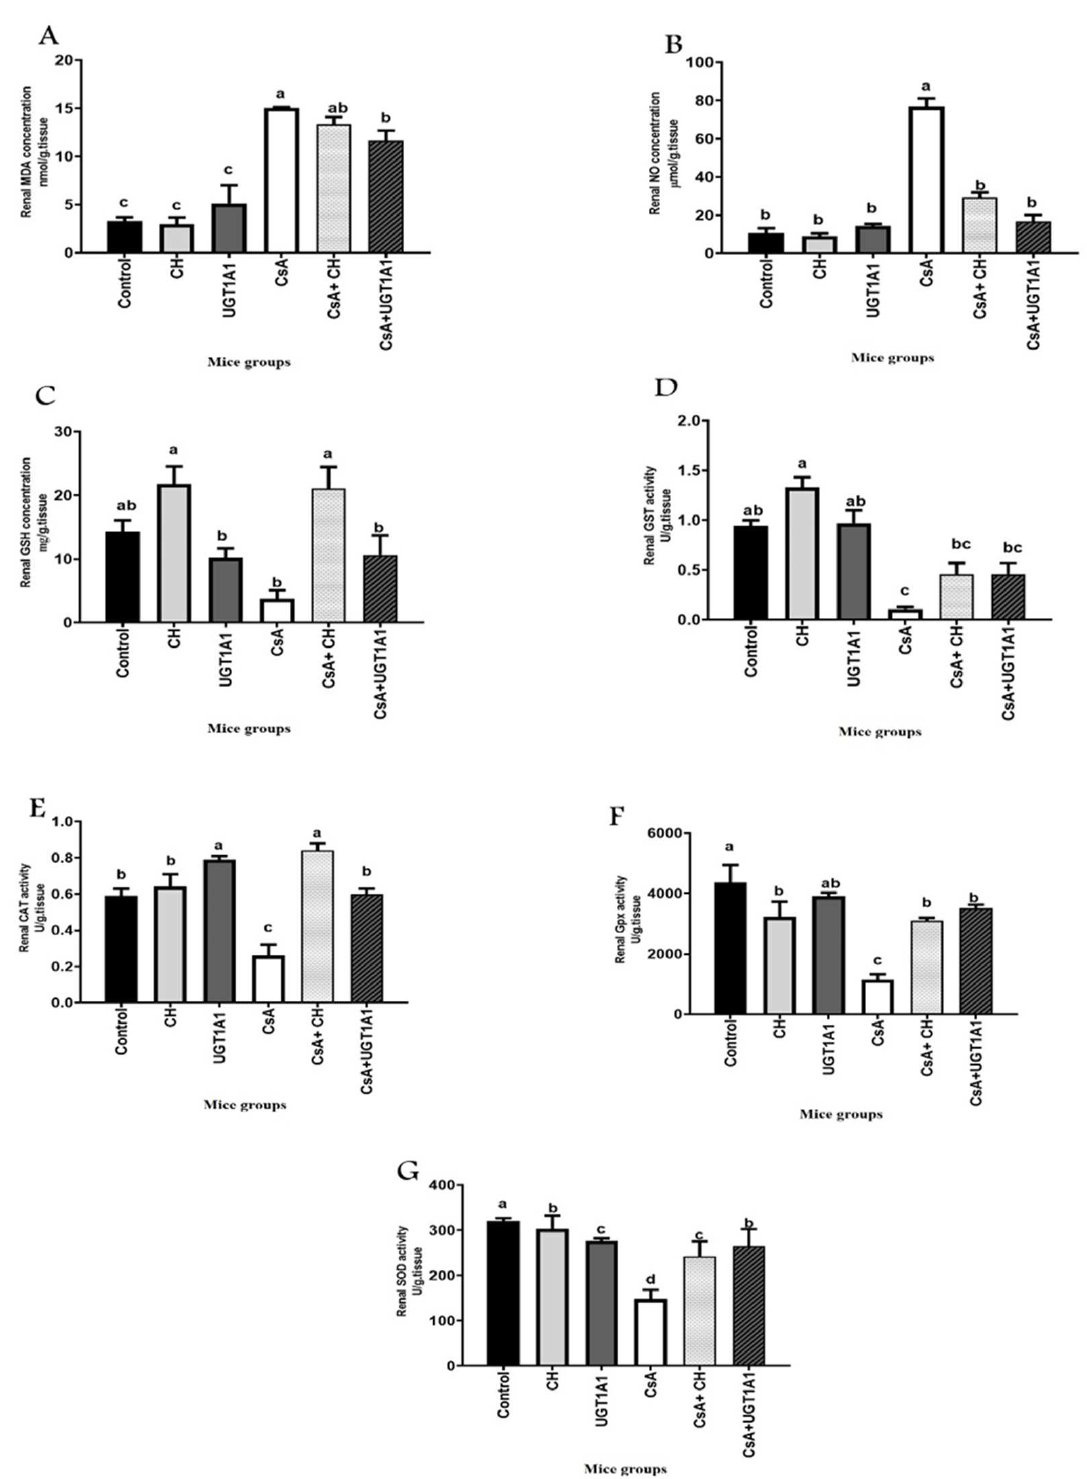
Figure 3. Physiological unconjugated hyperbilirubinemia inhibits CsA-induced kidney oxidative stress: ( A ) malondialdehyde (MDA); ( B ) nitric oxide (NO); ( C ) reduced glutathione (GSH); ( D ) glutathione S-transferase (GST); ( E ) catalase (CAT); ( F ) glutathione peroxidase (GPx), and ( G ) superoxide dismutase (SOD). Values are expressed as mean ± SEM ( n = 8). Means of different letters are statistically different ( p < 0.05) (ANOVA; Duncan’s post hoc analysis).